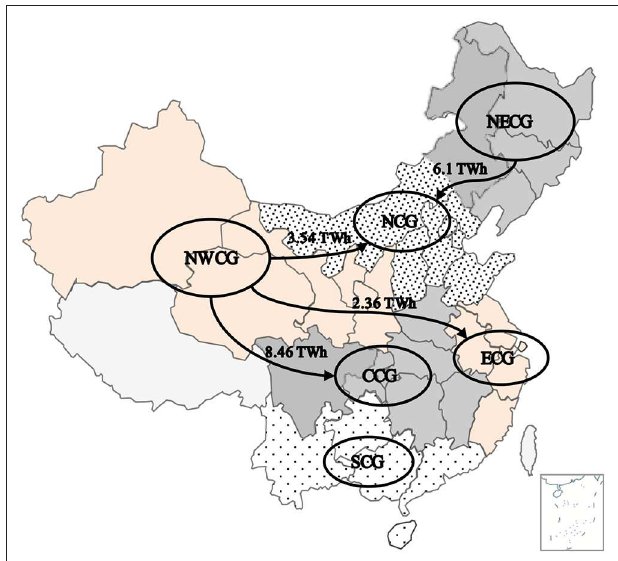
FIGURE 2 | Trans-regional accommodation of non-hydro renewable energy power in